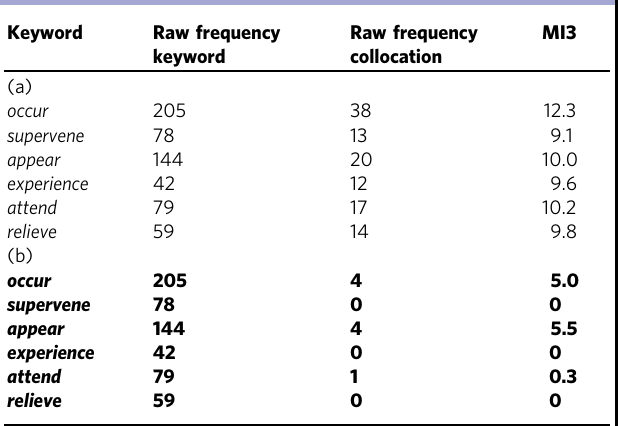
Table 11 (a) Verbal collocates of SYMPTOM, raw frequency = 348. (b) Verbal collocates of SIGN, raw frequency = 66.